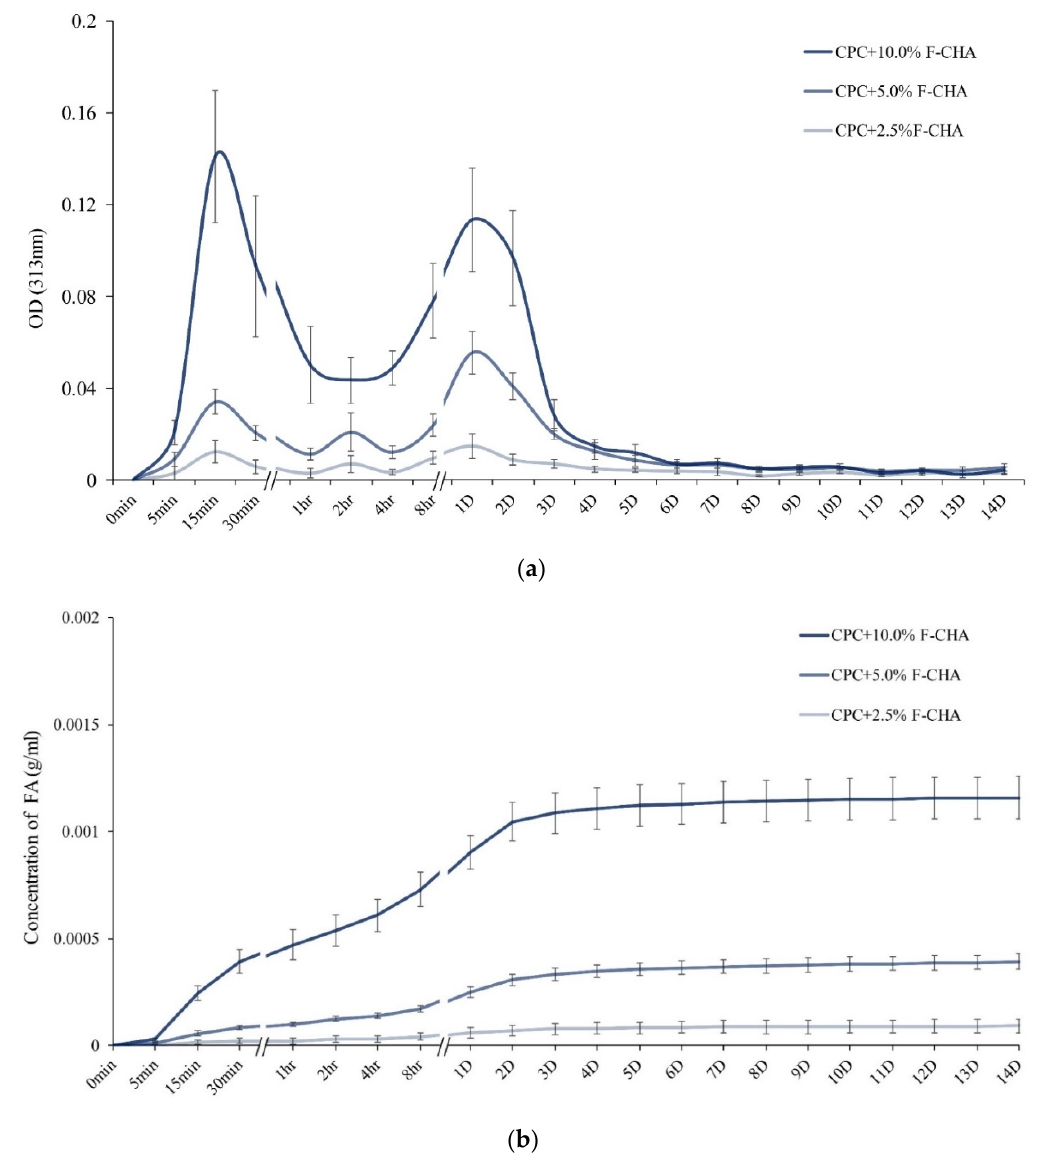
Figure 5. Individual time-release plots of ferulic acid ( a ) and cumulative release of carbonated apatite nanorods impregnated ( b ) with different concentrations of ferulic acid after immersion in ddH 2 O. The phenomenon of double-release peaks could be observed ( n = 5).